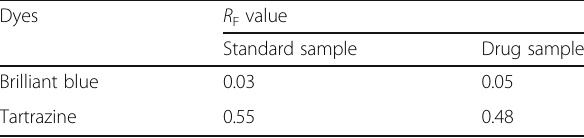
Table 9 Identification of tartrazine (in Roscillin R ) and brilliant blue (in Ambrodil * S) according to their R F values Dyes R F value Standard sample Drug sample Brilliant blue 0.03 0.05 Tartrazine 0.55